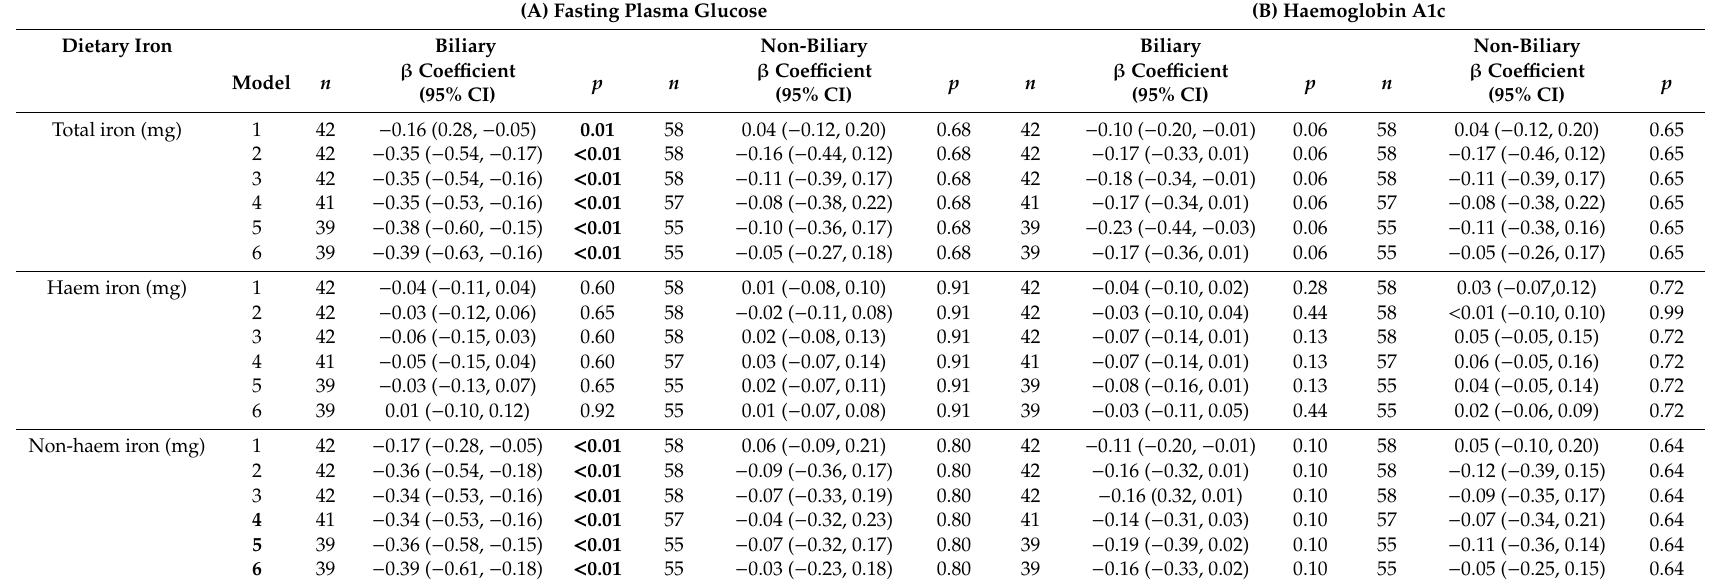
Table 3. Association between (A) fasting plasma glucose, (B) haemoglobin A1c and dietary iron in the sub-groups stratified by aetiology of acute pancreatitis. (A) Fasting Plasma Glucose (B) Haemoglobin